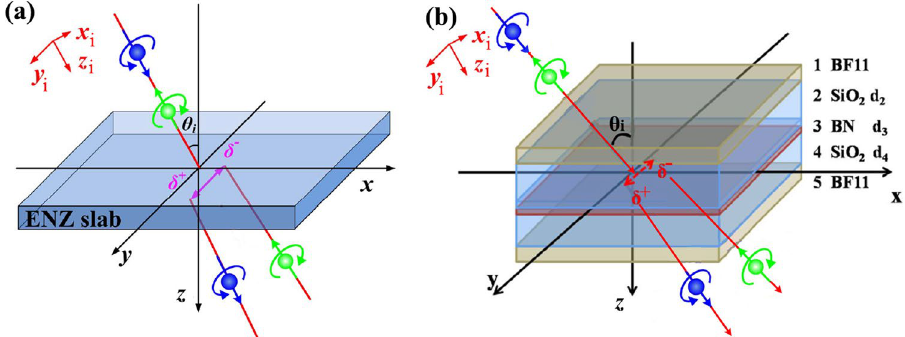
Figure 4. Illustration of the transmitted photonic SHE through an ENZ slab (a) and a ROTE structure (b) .